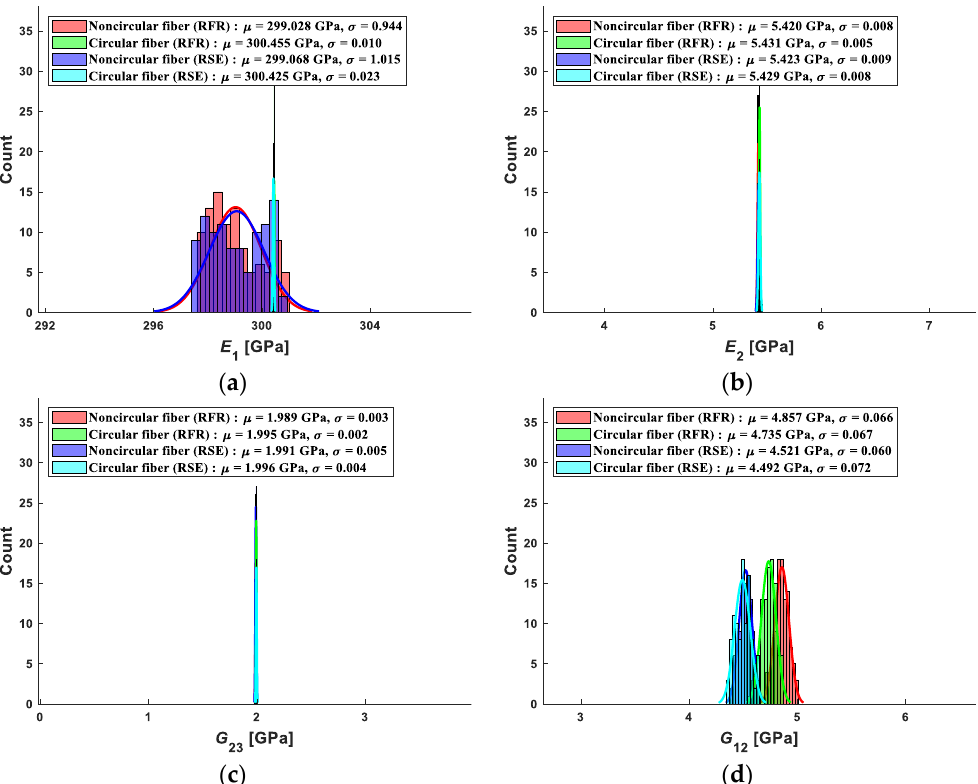
Figure 9. Effective elastic properties: ( a ) E